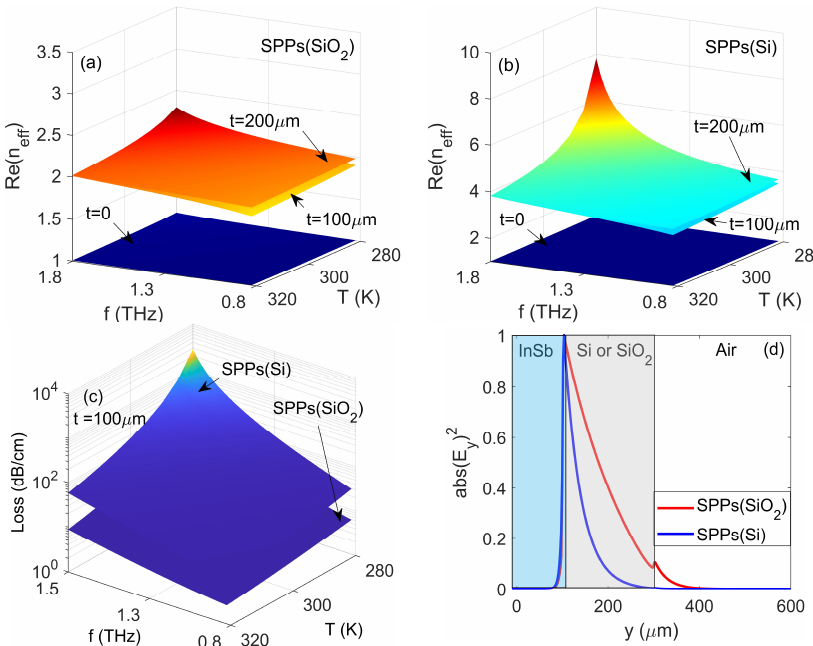
Figure 2. Values of Re( n eff ) as functions of f and T with different t for ( a ) SPPs(SiO 2 ) and ( b ) SPPs(Si) modes. ( c ) Dependence of mode losses for SPPs(SiO 2 ) and SPPs(Si) modes on parameters of f and T . ( d ) Normalized electric energy density patterns for SPPs(SiO 2 ) and SPPs(Si) modes with parameters of f = 1 THz, T = 300 K and t = 100 μm.